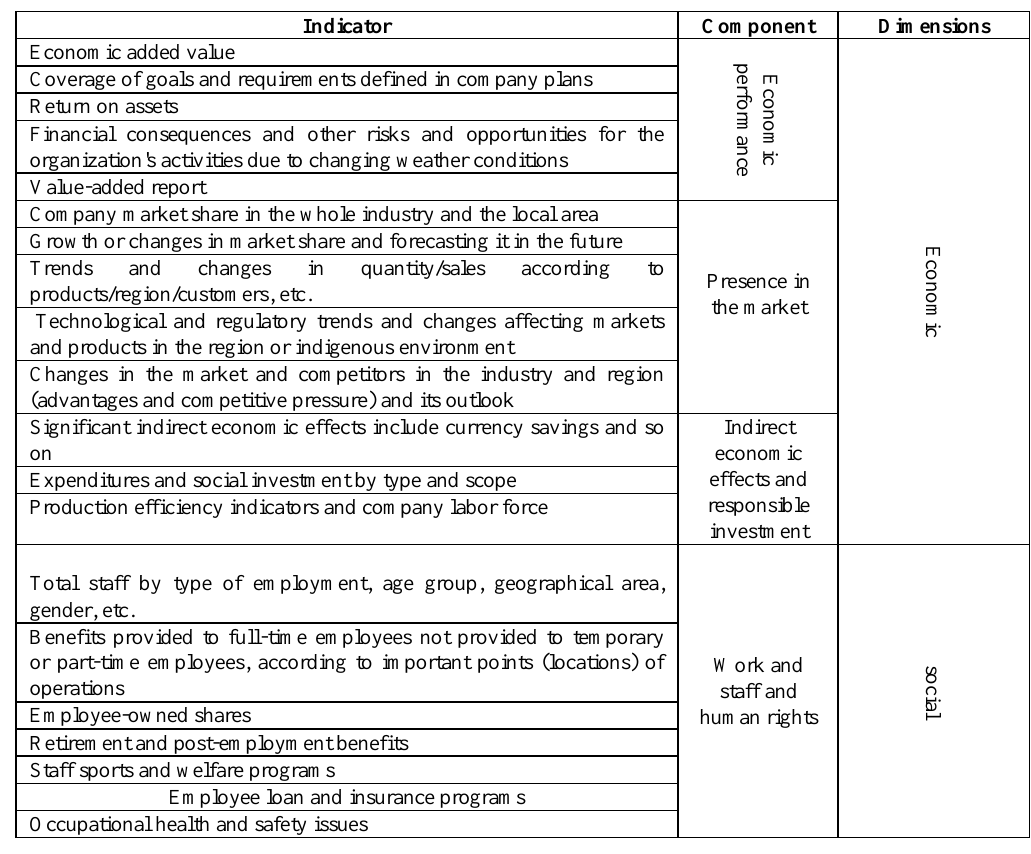
Table 1. Dimensions of sustainability